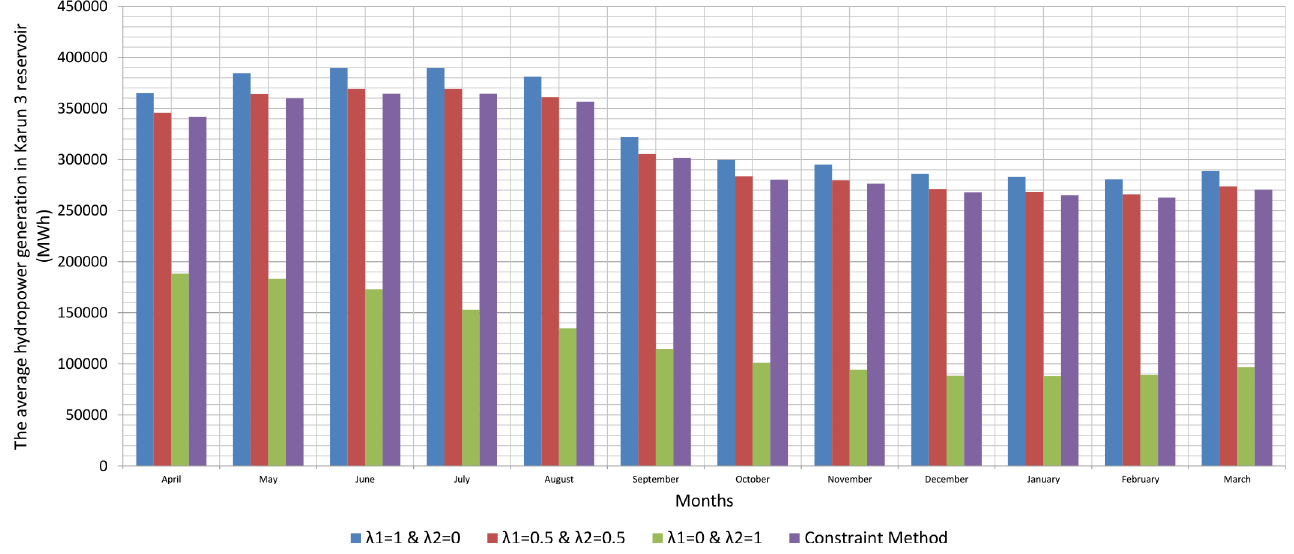
Fig 6. The average hydropower generation in Karun 3 reservoir (MWh).